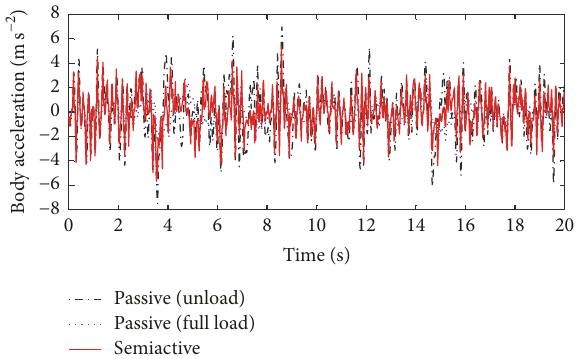
Figure 9: Body acceleration.